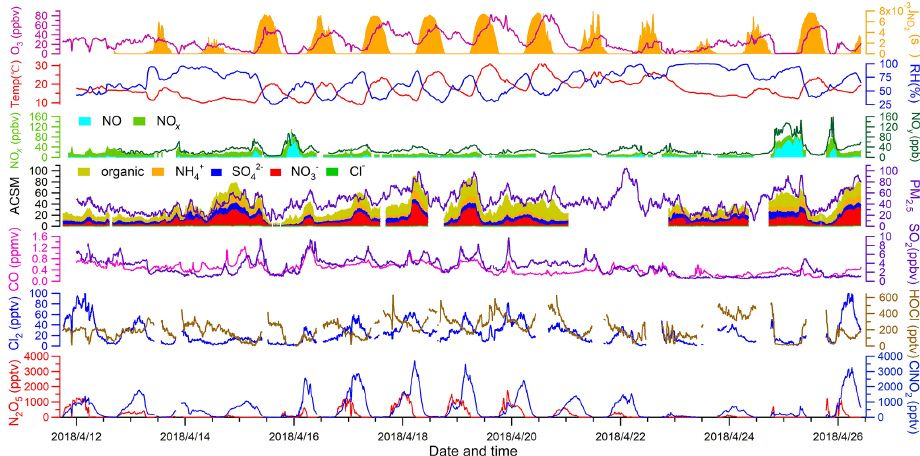
Figure 2. Time series of ClNO 2 , Cl 2 , and related measurements during field observations from 11 to 26 April 2018. Data gaps were caused by technical problems or calibrations.